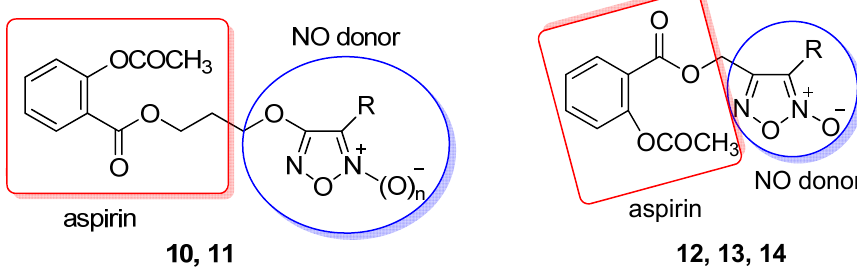
; 10a , n = 0, R = PhSO 2 ; 13 , R = CONH , 14 , R = CN) [42]. 3 2